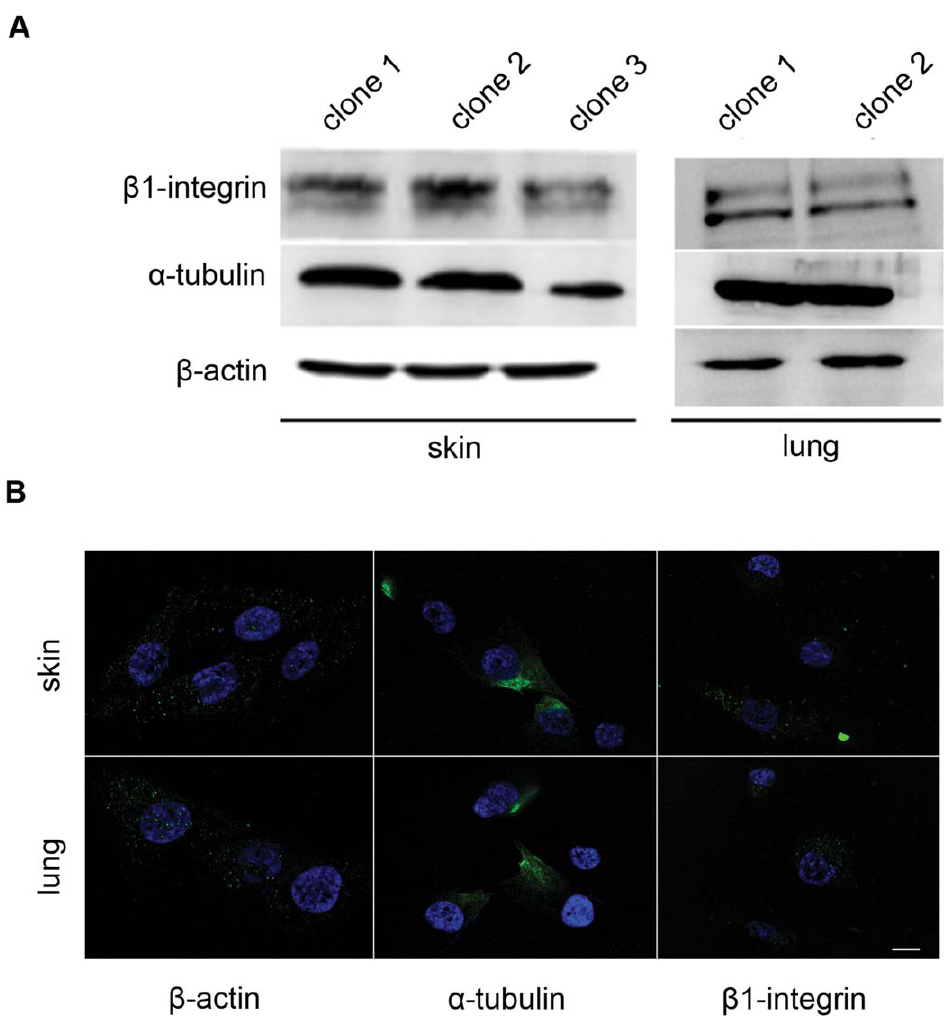
Figure 3. Cytoskeletal protein expression and localization in MPCs. A. Western blot showing constitutive expression of cytoskeletal components in mesenchymal precursors from skin and lung. One out of three independent experiments is shown. B. Representative fluorescence images of skin and lung MPCs, showing the distribution of a -actin, b -tubulin and b 1-integrin rabbit anti-mouse antibody). Scale bar, 1 m M.